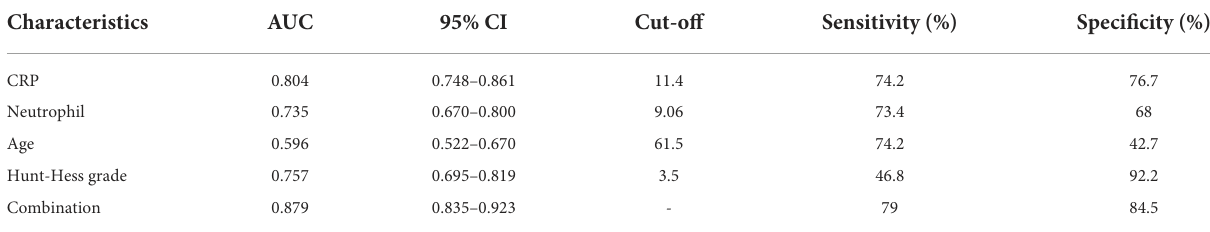
TABLE 6 The AUC, cut-off value, sensitivity, specificity from the ROC curve (Based on good prognosis group, poor prognosis group). Characteristics